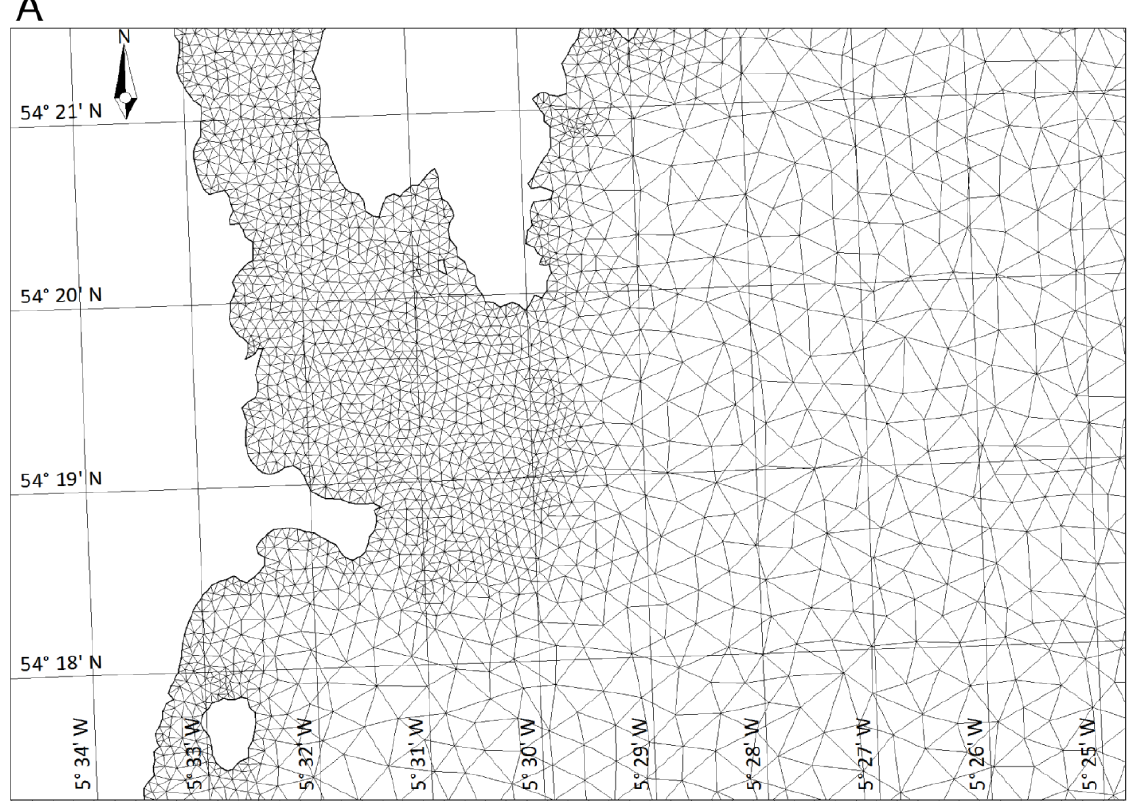
Figure 3. Detailed mesh of the entrance to Strangford Lough ( A ) and inside Strangford Lough, characterised by islands and pladdies ( B